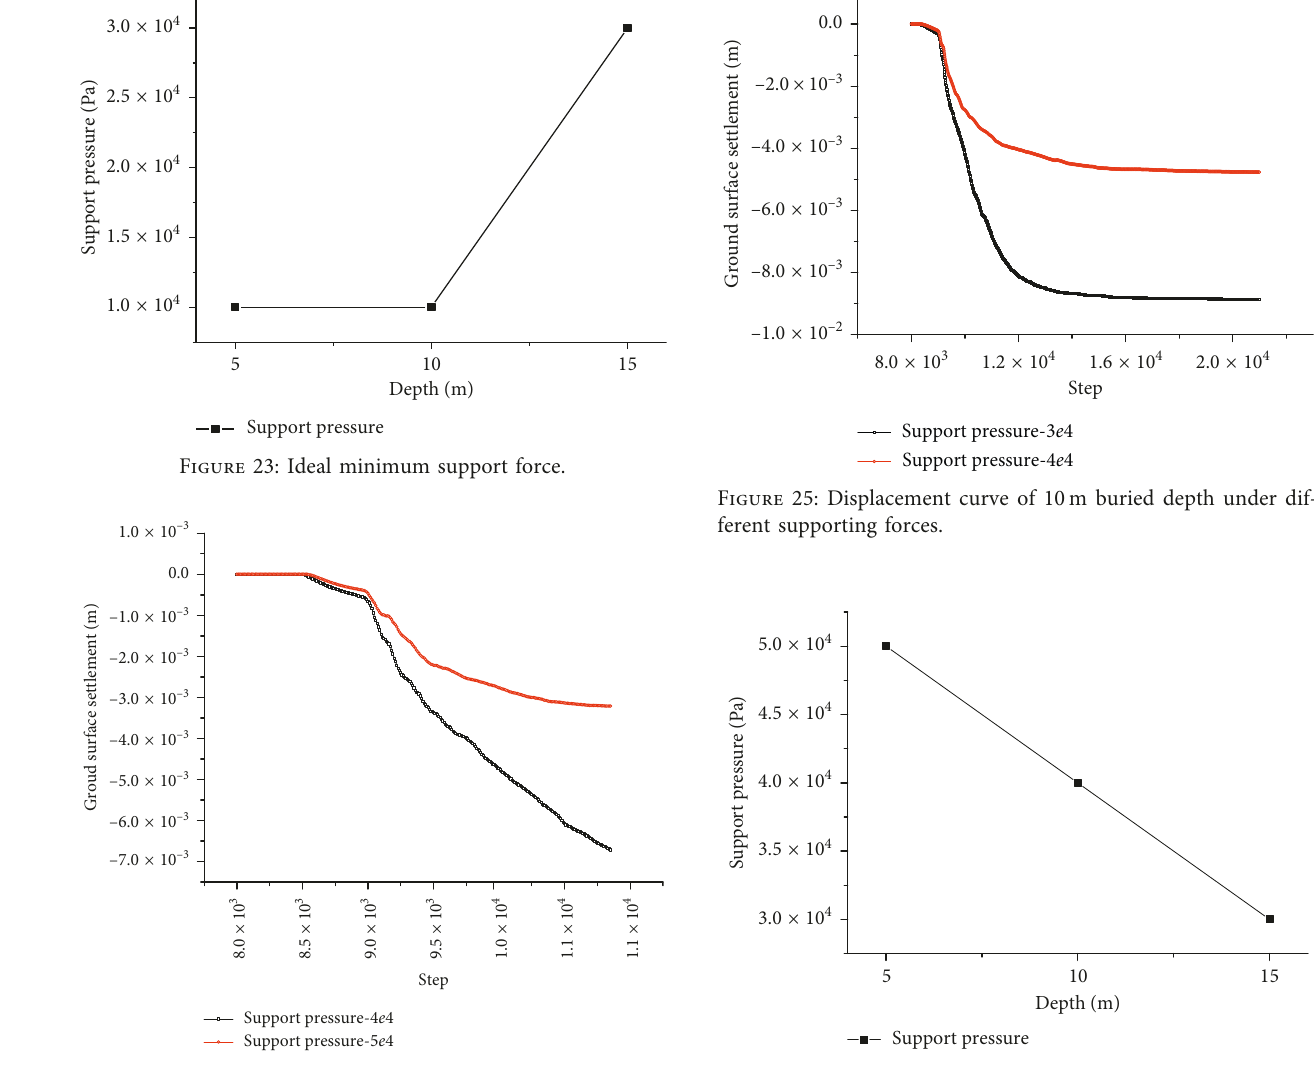
Figure 24: Displacement curve of 5m buried depth under different supporting forces.